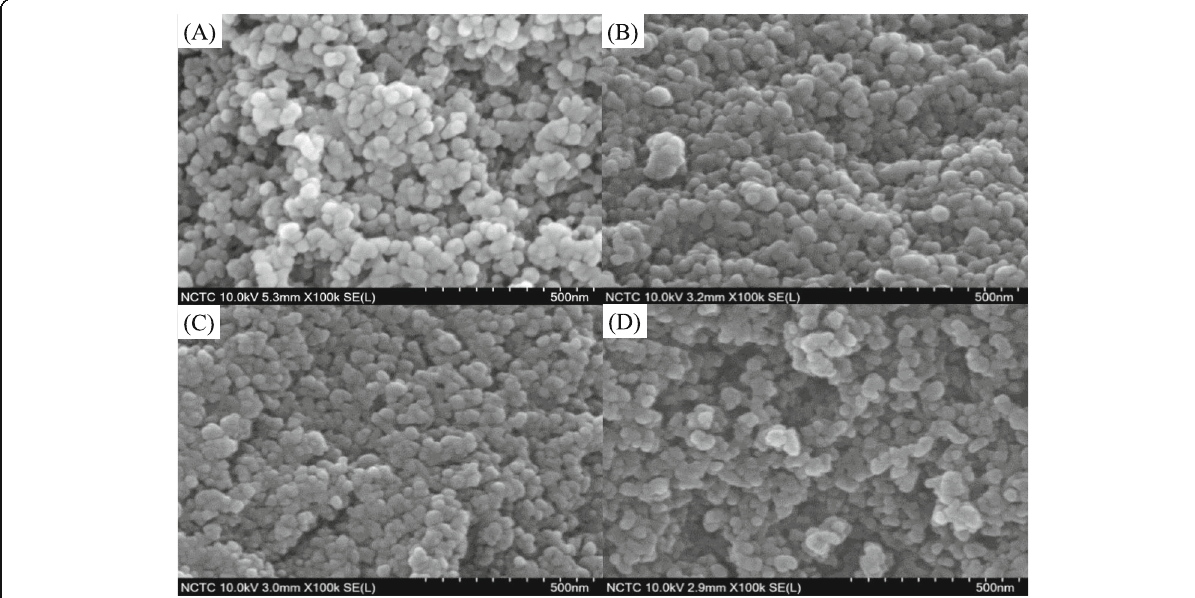
Fig. 4 Representative FESEM images of ( a ) HMS, ( b ) NRHMS, ( c ) NRHMS(2.5), and ( d ) NRHMS(10) at a magnification of